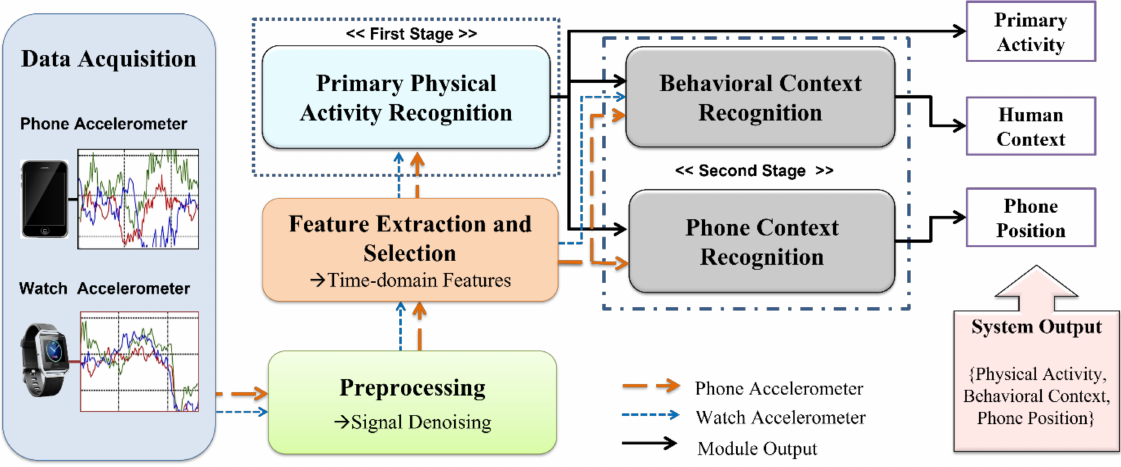
Figure 2. Block diagram of the proposed method for activity recognition in-the-wild